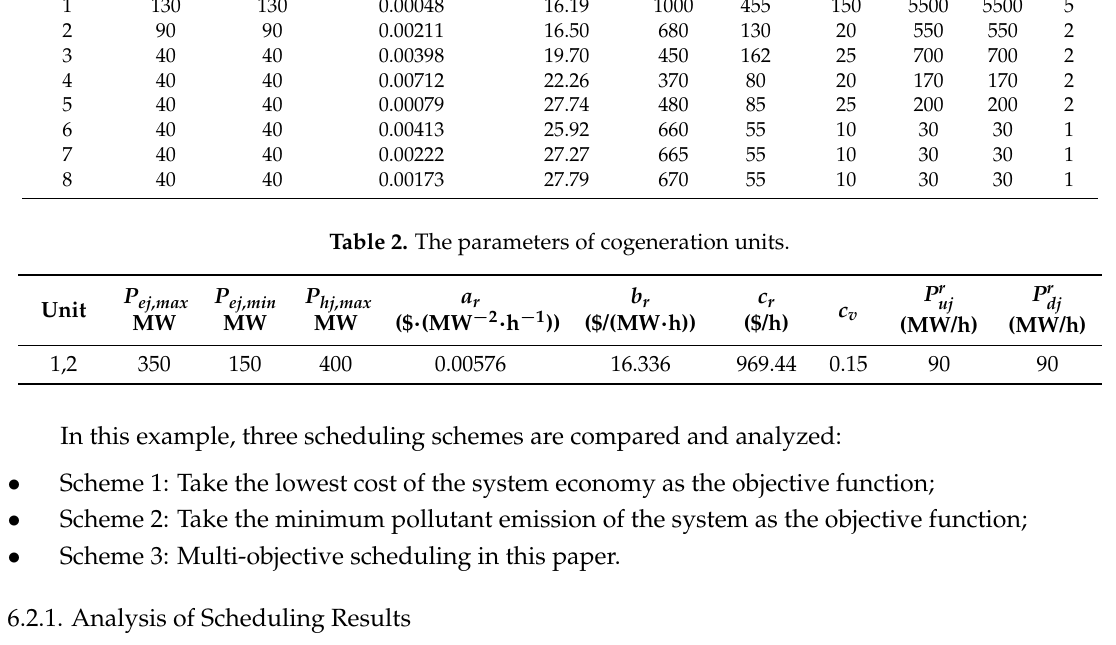
Table 3. Results of three scheduling schemes. 345